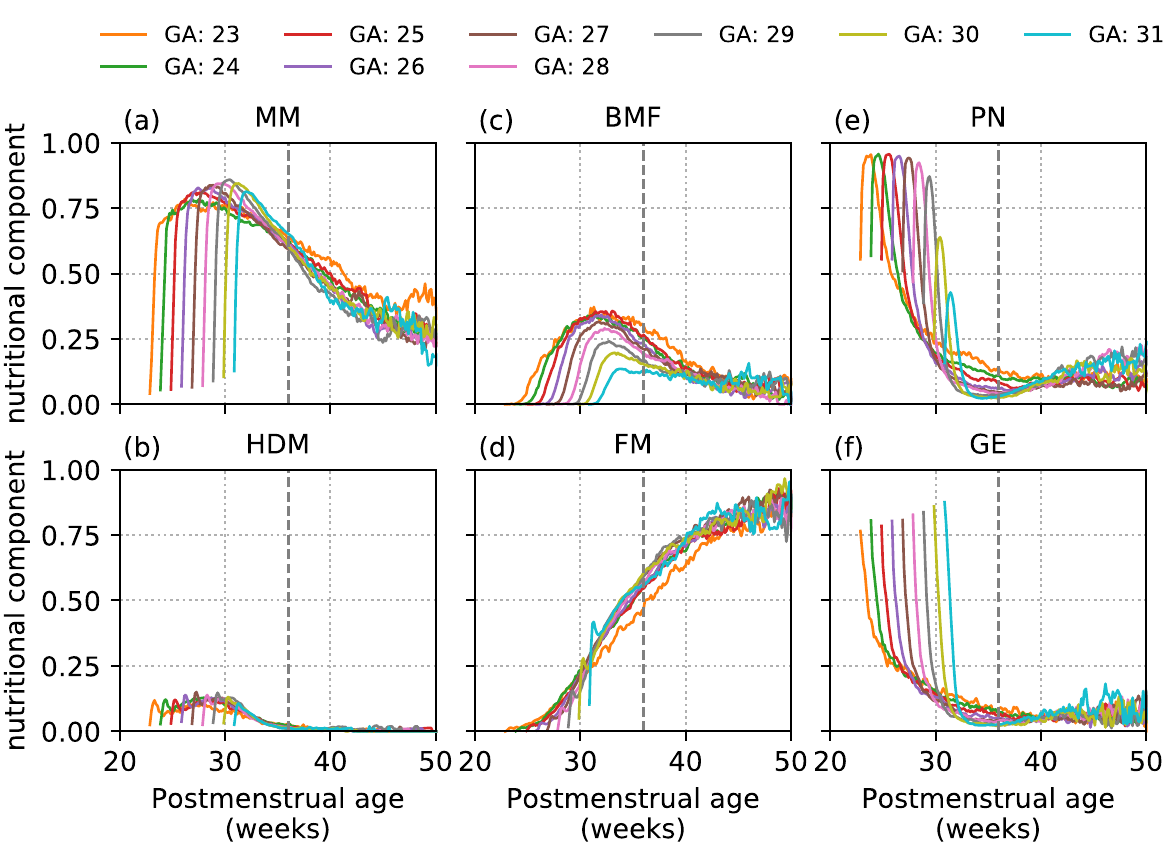
Figure 1. Time curves of the proportion of infants receiving a given nutritional component Time is expressed as postmenstrual age in weeks. Curves are stratified and colour-coded by infant gestational age groups (GA), computed on the set of infants still in care at a given postmenstrual age. The vertical grey dashed line indicates 36 weeks postmenstrual age. In ( a – f ) we show the proportion of infants who are still in care at a given postmenstrual age receiving each of the six components (MM: Maternal Milk, HDM: Human Donor Milk, BMF: Breast Milk Fortifier, FM: Formula Milk, PN: Parenteral Nutrition, GE: Glucose Electrolyte solution). We only considered GA > 22 weeks as, due to small sample size, values for GA = 22 weeks exhibited too much variation for meaningful